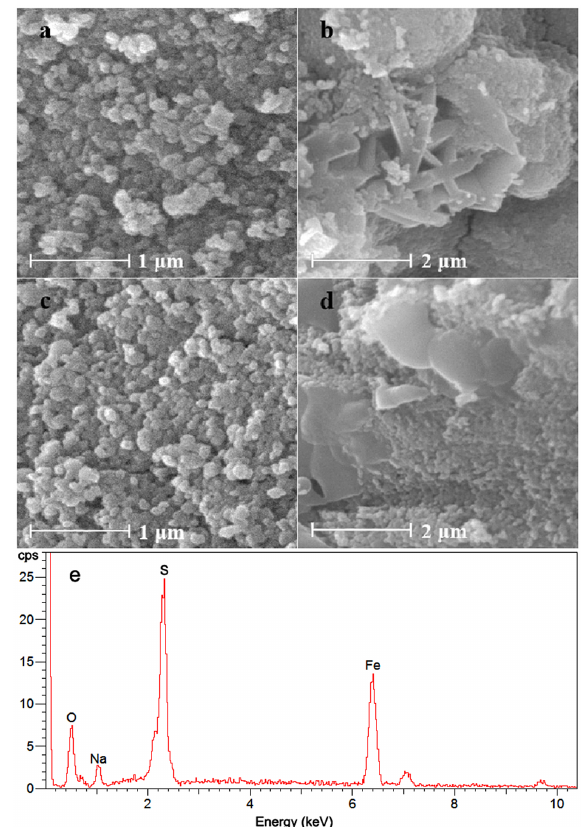
Figure 7. SEM images and EDX spectrum. Top panels: SEM im- ages of FN-24 (a, b) and FN-90 (c, d) particles before (left) and after (right) exposure to 3ppm SO 2 at 298K for 240min. Bottom panel: typical EDX spectrum of the flaky